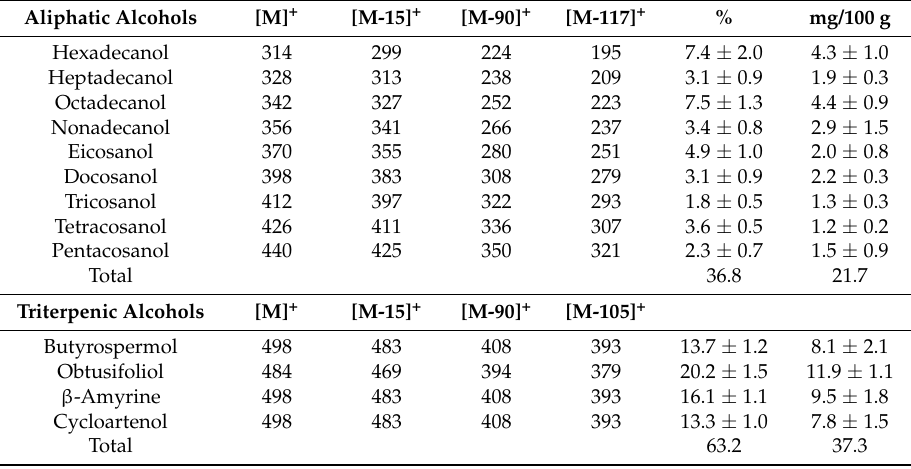
structure, respectively. Table 4. Fragmentation ions used for identification of TMSE alcohols of pumpkin ( C. maxima , var. Berrettina) seed oil and alcohol composition (% and mg/100 g oil; average value ± SD, n =